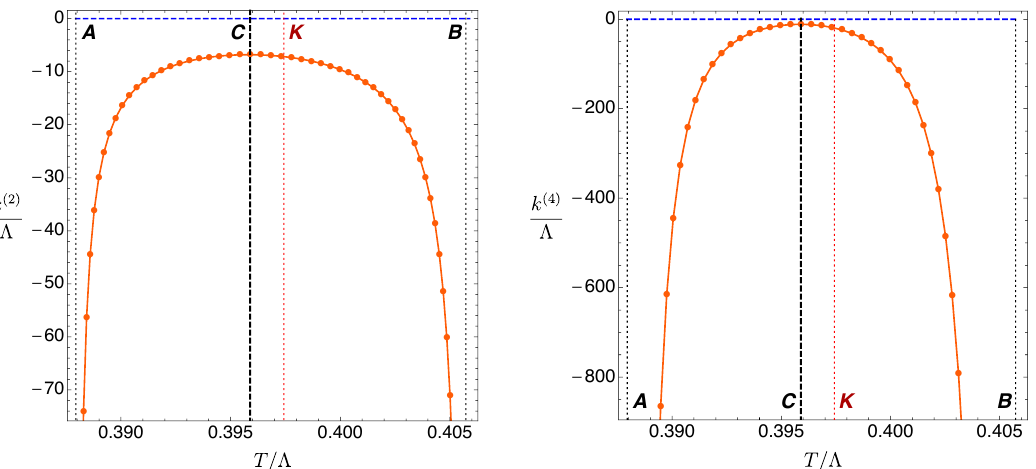
Figure 9 . Wavenumber corrections k (2) (left panel) and k (4) (right panel), as defined in (2.61b), as a function of the uniform brane temperature. For reference, ˆ T C ’ 0 . 3958945 and the maximum of the instability occurs for ˆ T K ’ 0 . 397427